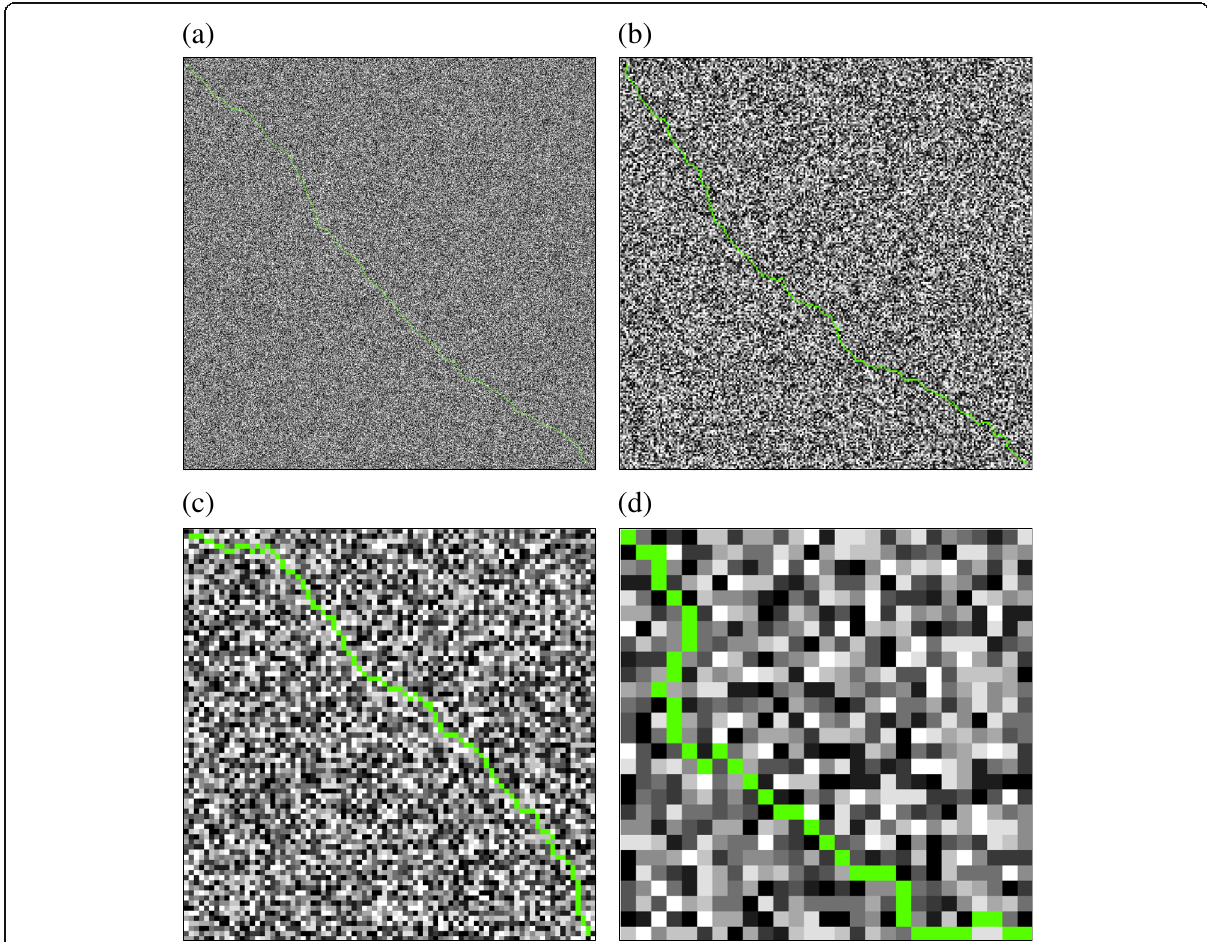
Fig. 1 Least-cost paths (colored in green) between a source and sink on random cost surfaces with resolutions of a 1, b 3, c 9, and d 27. Note that darker shades represent higher cost